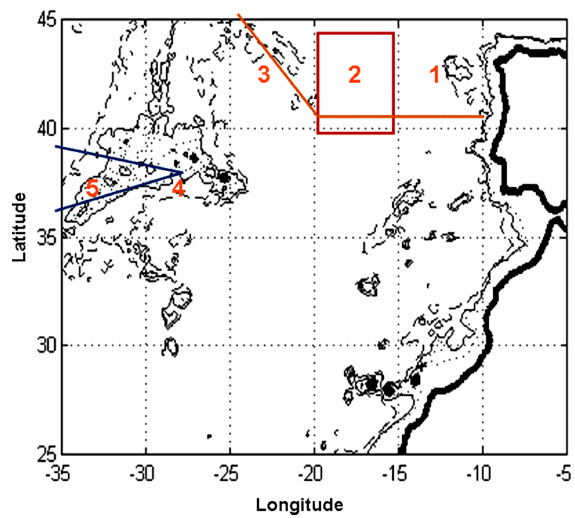
Figure A1. A map of sections along which comparison with the previous literature results in 5 ◦ × 5 ◦ squares are made: blue line – Hinrichsen and Tomczak (1993); orange line – Alvaréz et al. (2004); red square – Barbero et al. (2010). Squares, where the results are averaged are